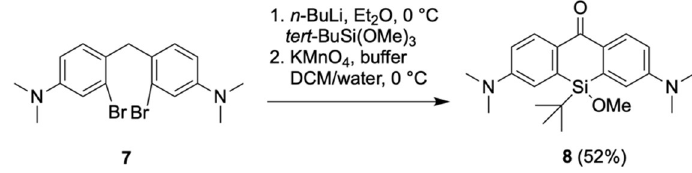
Figure 3. Si-xanthone 8 can be readily synthesized from bis-aniline 7